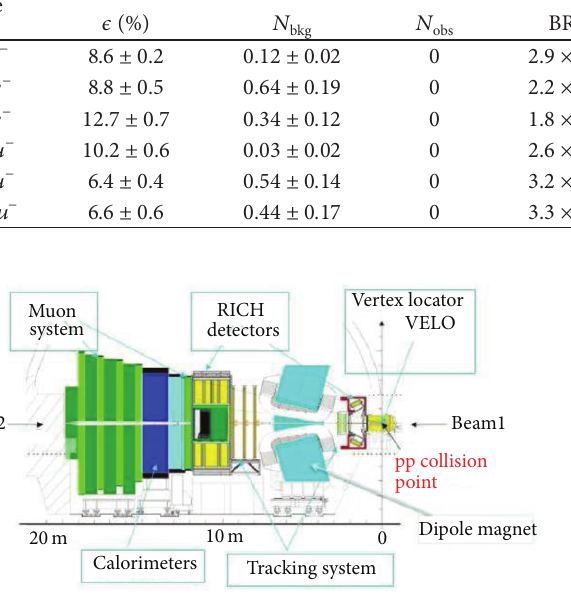
Figure 34: Schematic view of the LHCb